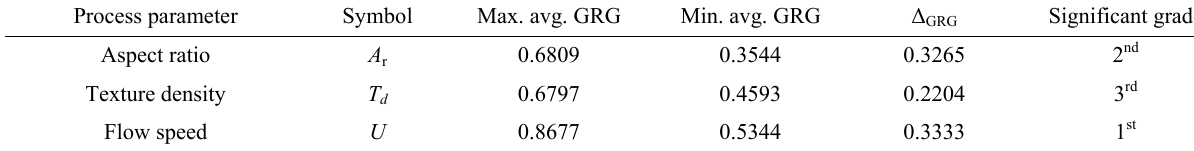
Fig. 15 Optimum (a) texture geometry and (b) pressure profile for triangle T2 bottom profile. Table 9 The most significant process parameter of triangle T2 bottom profile.